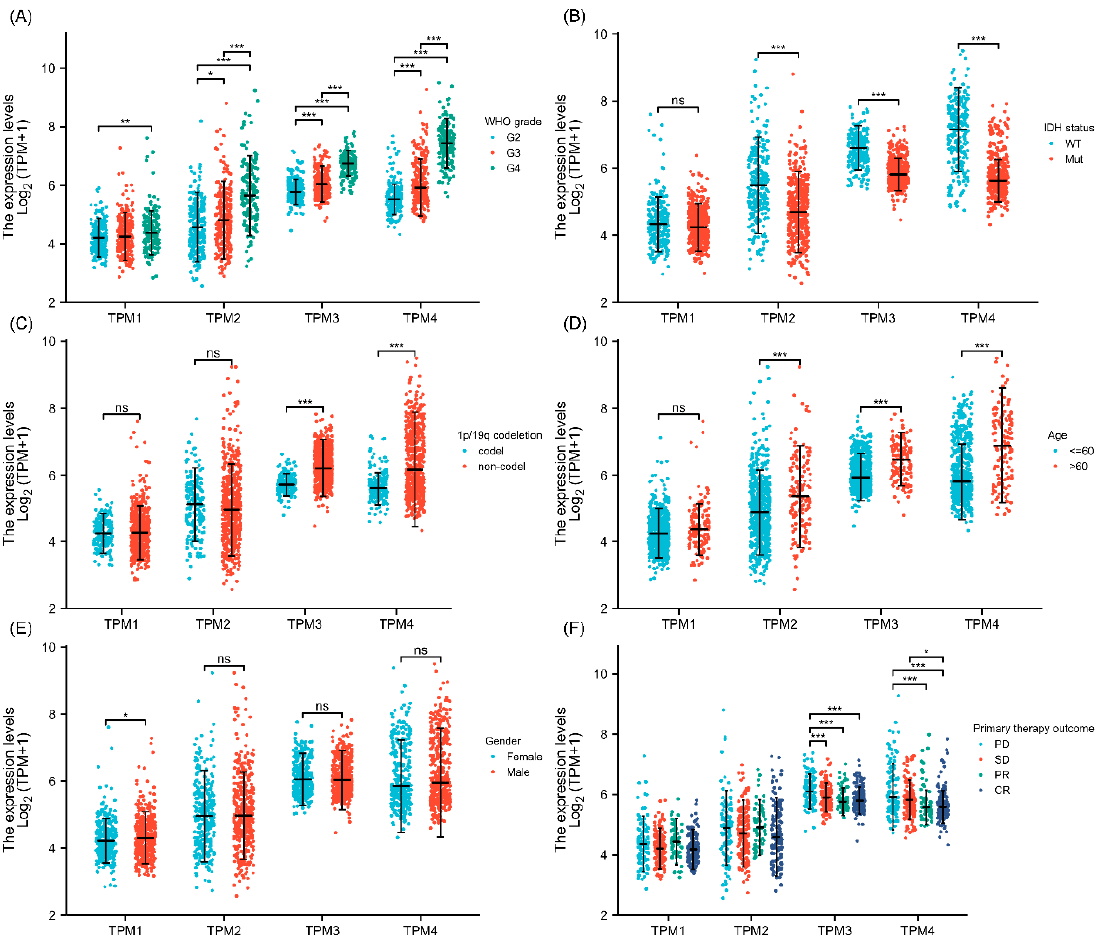
Figure 2. The association between TPM expressions and clinical characteristics. ( A ) Correlations between TPM expressions and WHO grade. ( B ) Correlations between TPM expressions and IDH status. ( C ) Correlations between TPM expressions and 1p/19q status. ( D ) Correlations between TPM expressions and age. ( E ) Correlations between TPM expressions and gender. ( F ) Correlations between TPM expressions and primary therapy outcomes (PD: progressive disease; SD: stable disease; PR: partial response; CR: complete response). (ns, no significance; *, p < 0.05; **, p < 0.01; ***, p <